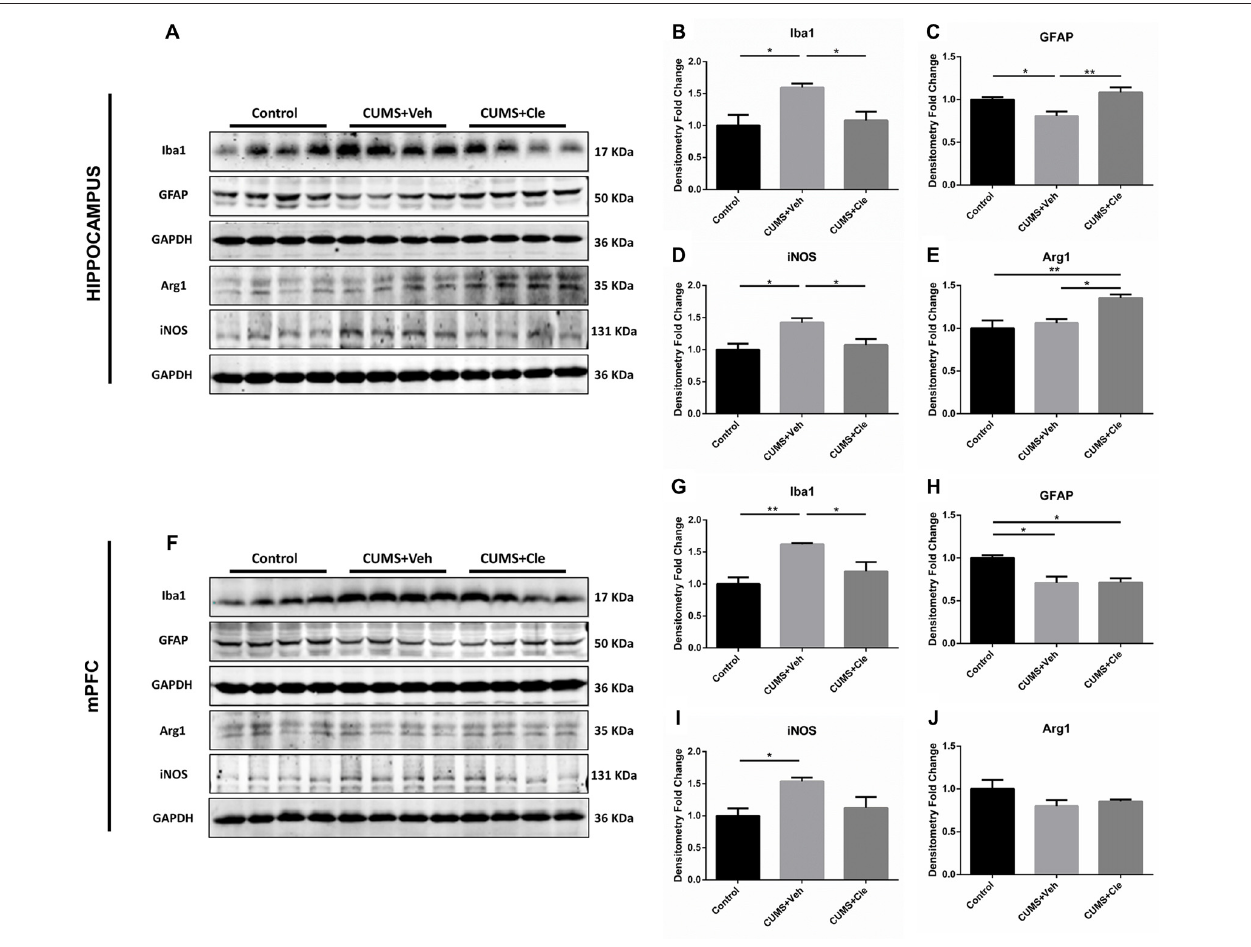
FIGURE 4 | Detections of glial activation biomarkers in hippocampus and mPFC. (A–E) Western blot analysis of the hippocampal specimens indicated that, CUMS treatment inclined to increase the protein level of ionized calcium binding adaptor molecule 1 (Iba1) and inducible nitric oxide synthase (iNOS), as well as decrease the protein expression of glial fibrillary acidic protein (GFAP). Meanwhile, administration of clemastine could normalize these changes. Additionally, clemastine could upregulate Arg1 comparing to both Control and CUMS + Veh groups. (F–J) Similar with results of the hippocampus, chronic stress enhanced the expression of Iba1 and iNOS while suppressed the GFAP level in the brain region of mPFC. However, clemastine could only ameliorate the abnormality of Iba1 induced by CUMS. The expression of Arg1 remained unchanged in CUMS + Veh and CUMS + Cle groups compared with Control ( n = 4 for A–J , ∗ p < 0.05, ∗∗ p <